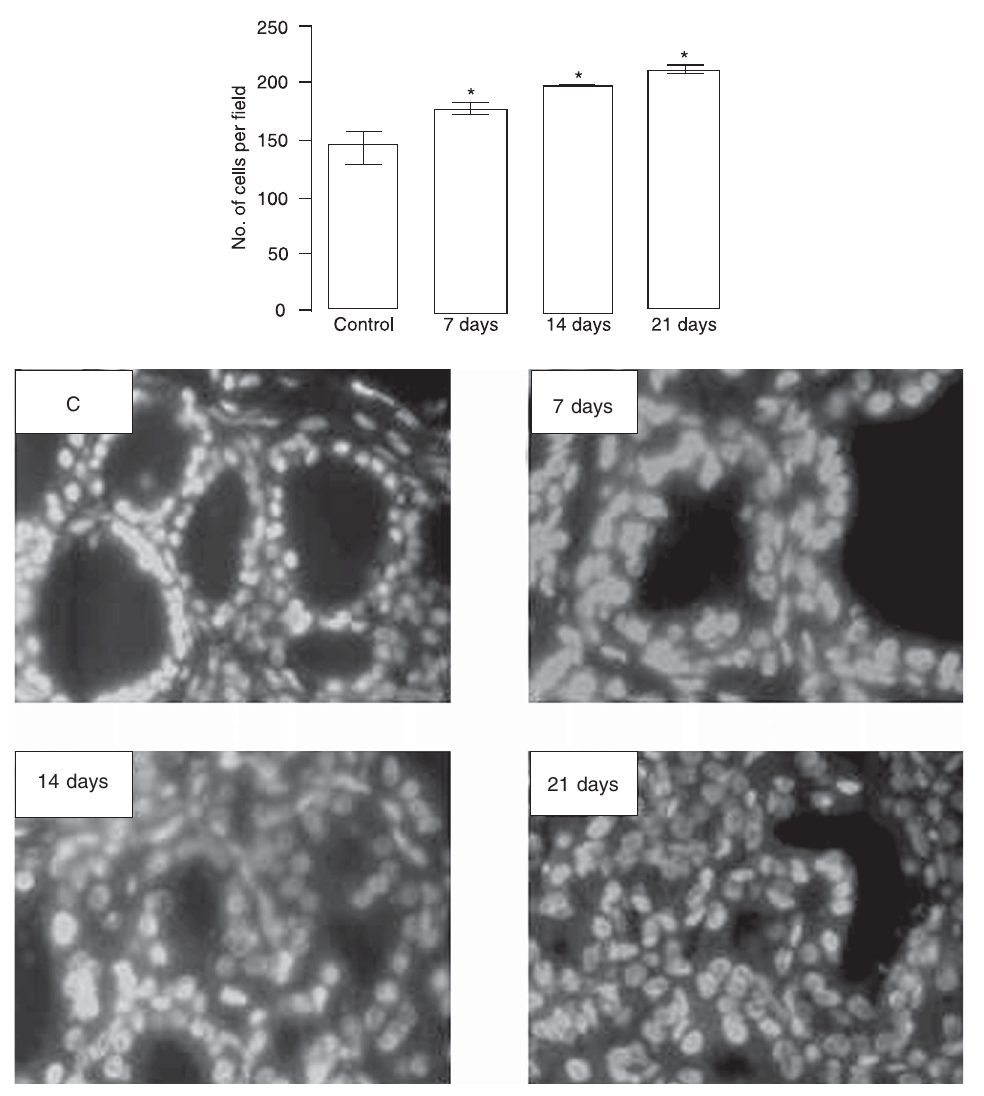
Figure 1. Increase in thyroid cell number during goitrogenesis. Thyroid tissue from rats treated with 0.03% methimazole in drinking water during different periods of time (7, 14, and 21 days) and from control (C) rats was embedded in paraffin and tissue sections were stained with 4',6'-diamidino-2-phenyl- indole for nucleus count. Data are reported as the mean ± SEM of three experiments with at least 3 rats in each group. *P < 0.05 compared to control (ANOVA followed by the New- man-Keuls multiple comparison test). 40X